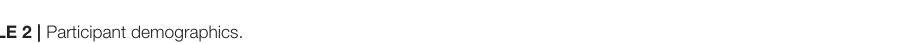
TABLE 2 | Participant